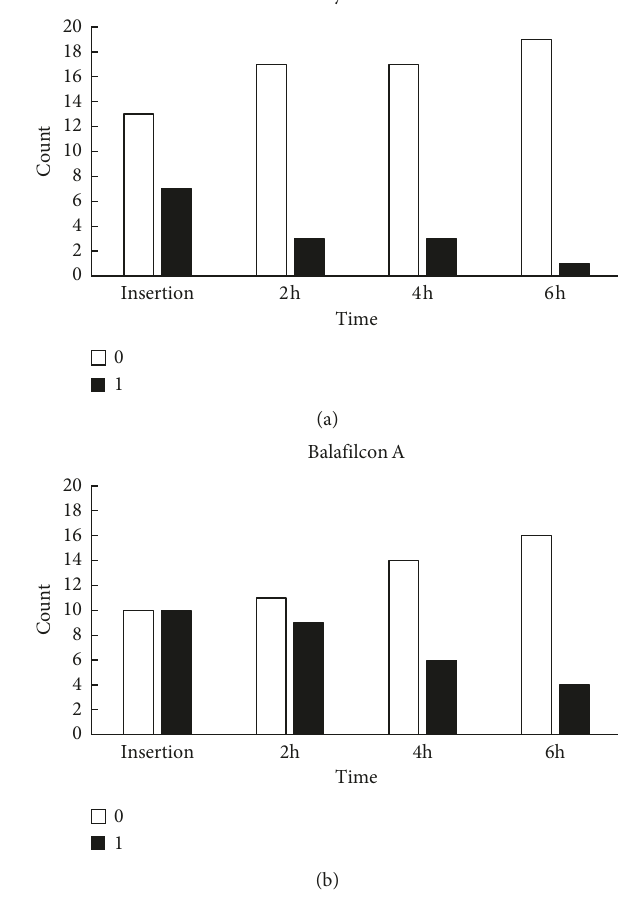
Figure 3: Time-dependent changes in PoLTF at the limbus. It was ranked as “1” if a gap was presented on the conjunctiva and “0” as the gap was absent. (a) Time-dependent changes in PoLTF at the limbus for galyfilcon A lenses and (b) balafilcon A lenses. Fre- quency of occurrence for PoLTF on the conjunctiva decreased over the study period compared to insertion.